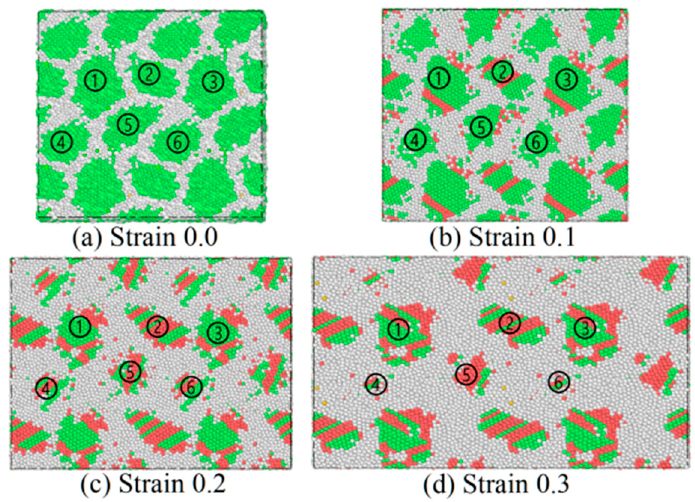
Figure 5. Atom snapshot of CoCrFeNiMn high-entropy alloy with the seed grain size of 3.0 nm stretched at a strain rate of 5 × 10 8 /s and a temperature of 300 K colored by CNA values. ( a ) Strain 0.0; ( b ) Strain 0.1; ( c ) Strain 0.2; ( d ) Strain 0.3.